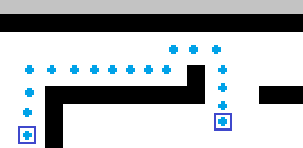
Fig. 4. Path of A ∗ mode gives a sequence of points to act as intermediary targets to help the agent reach the final target